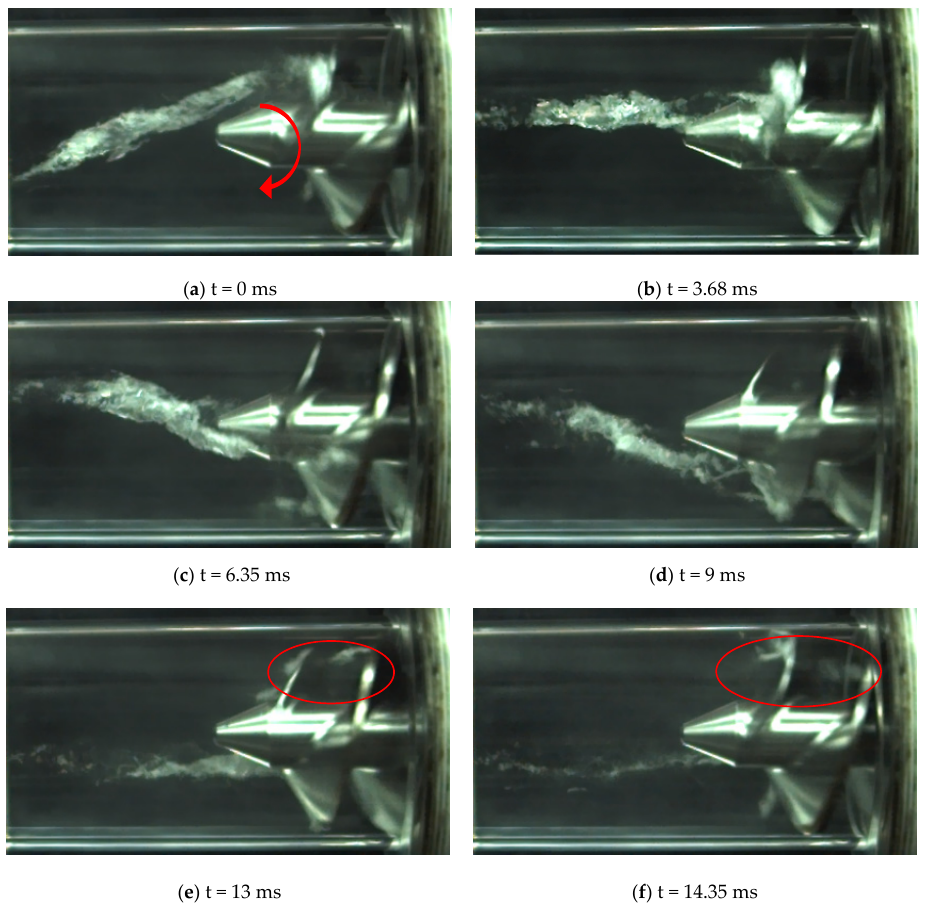
Figure 11. Vortex distribution at different times (Q = 0.14 Q d and NPSH = 10 m).